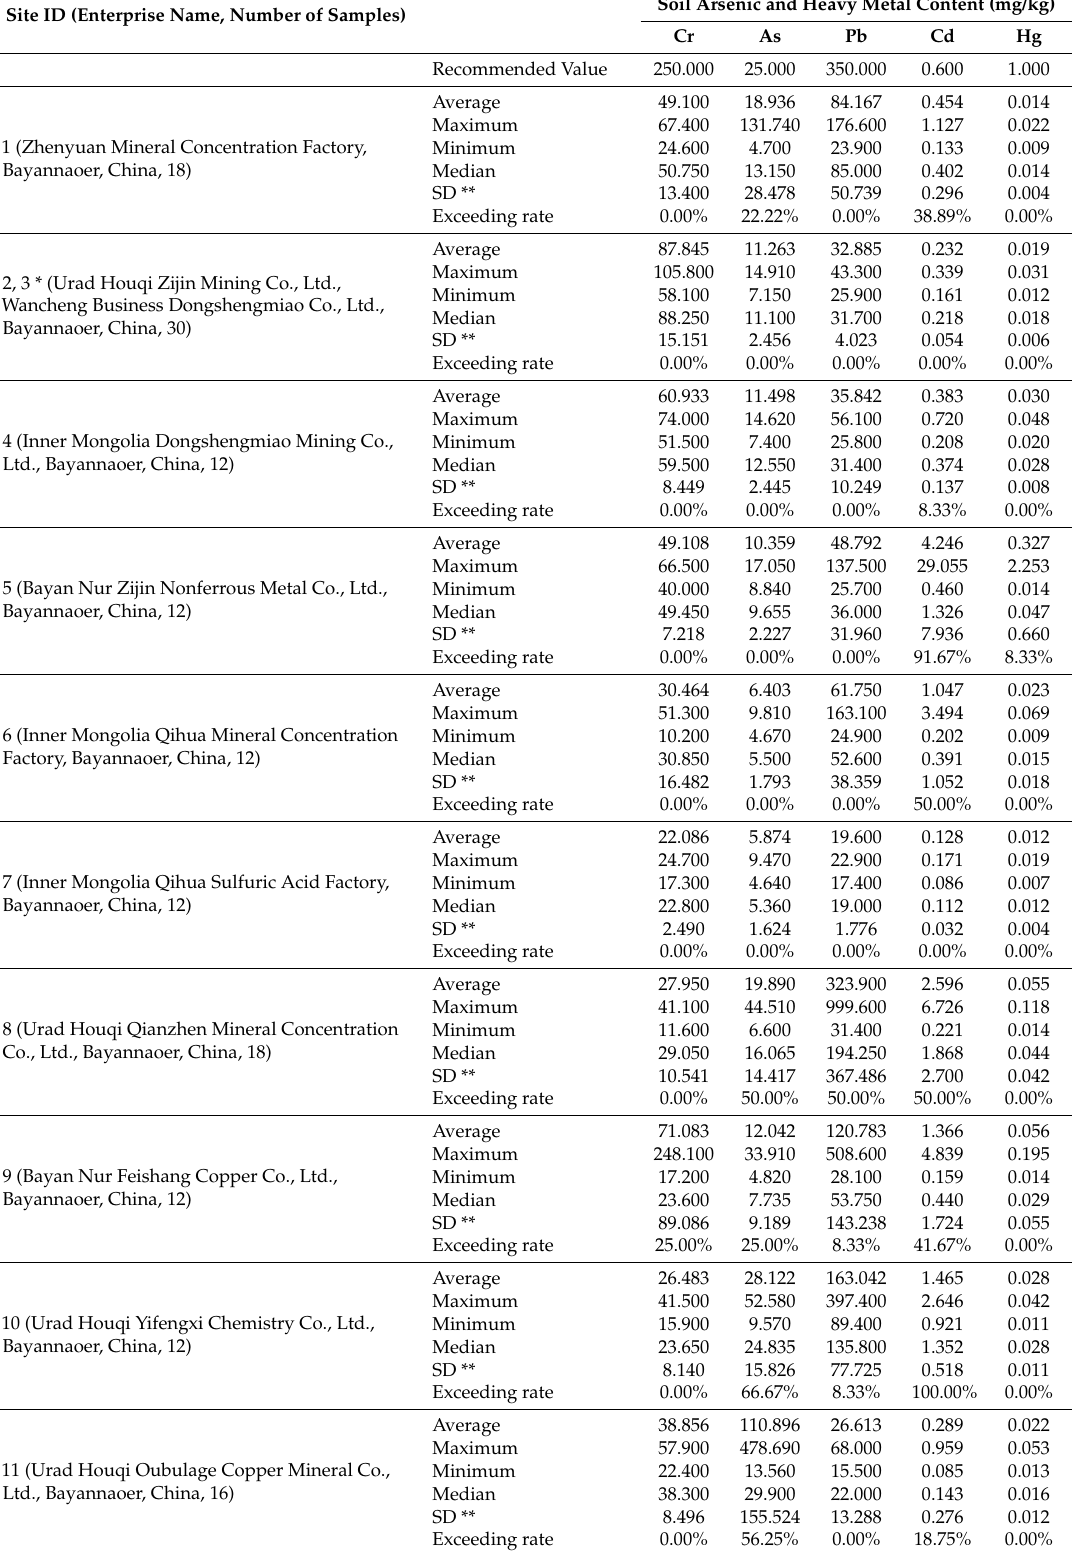
Table 3. Description of Cr, As, Pb, Cd and Hg in soils (0–20 cm) for each site and their exceeding standard rates (dry